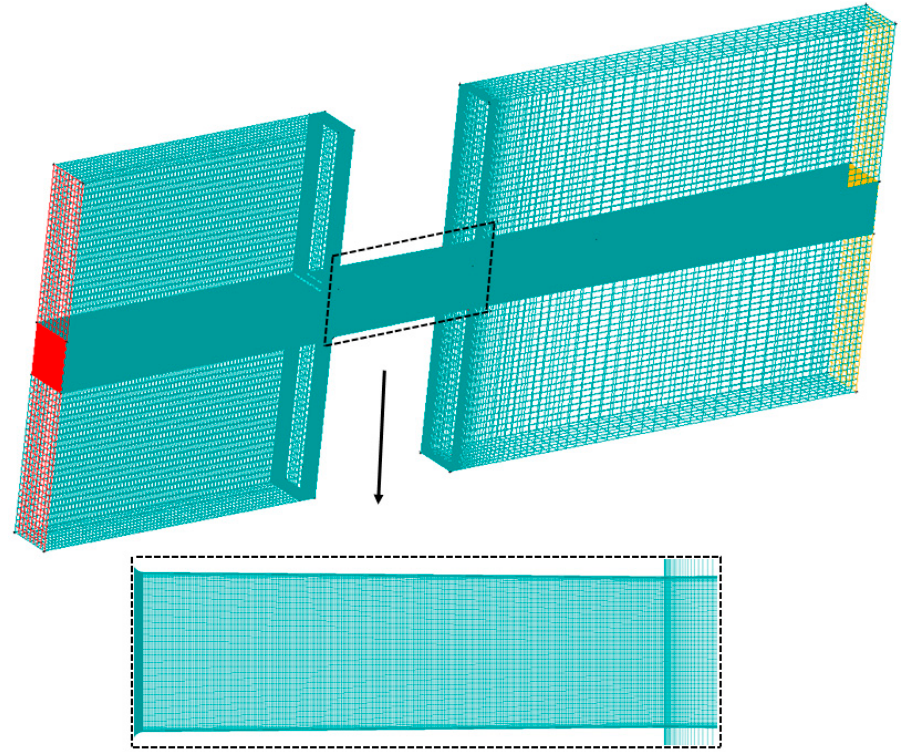
Figure 3. The simulation mesh model of the microchannel structure.